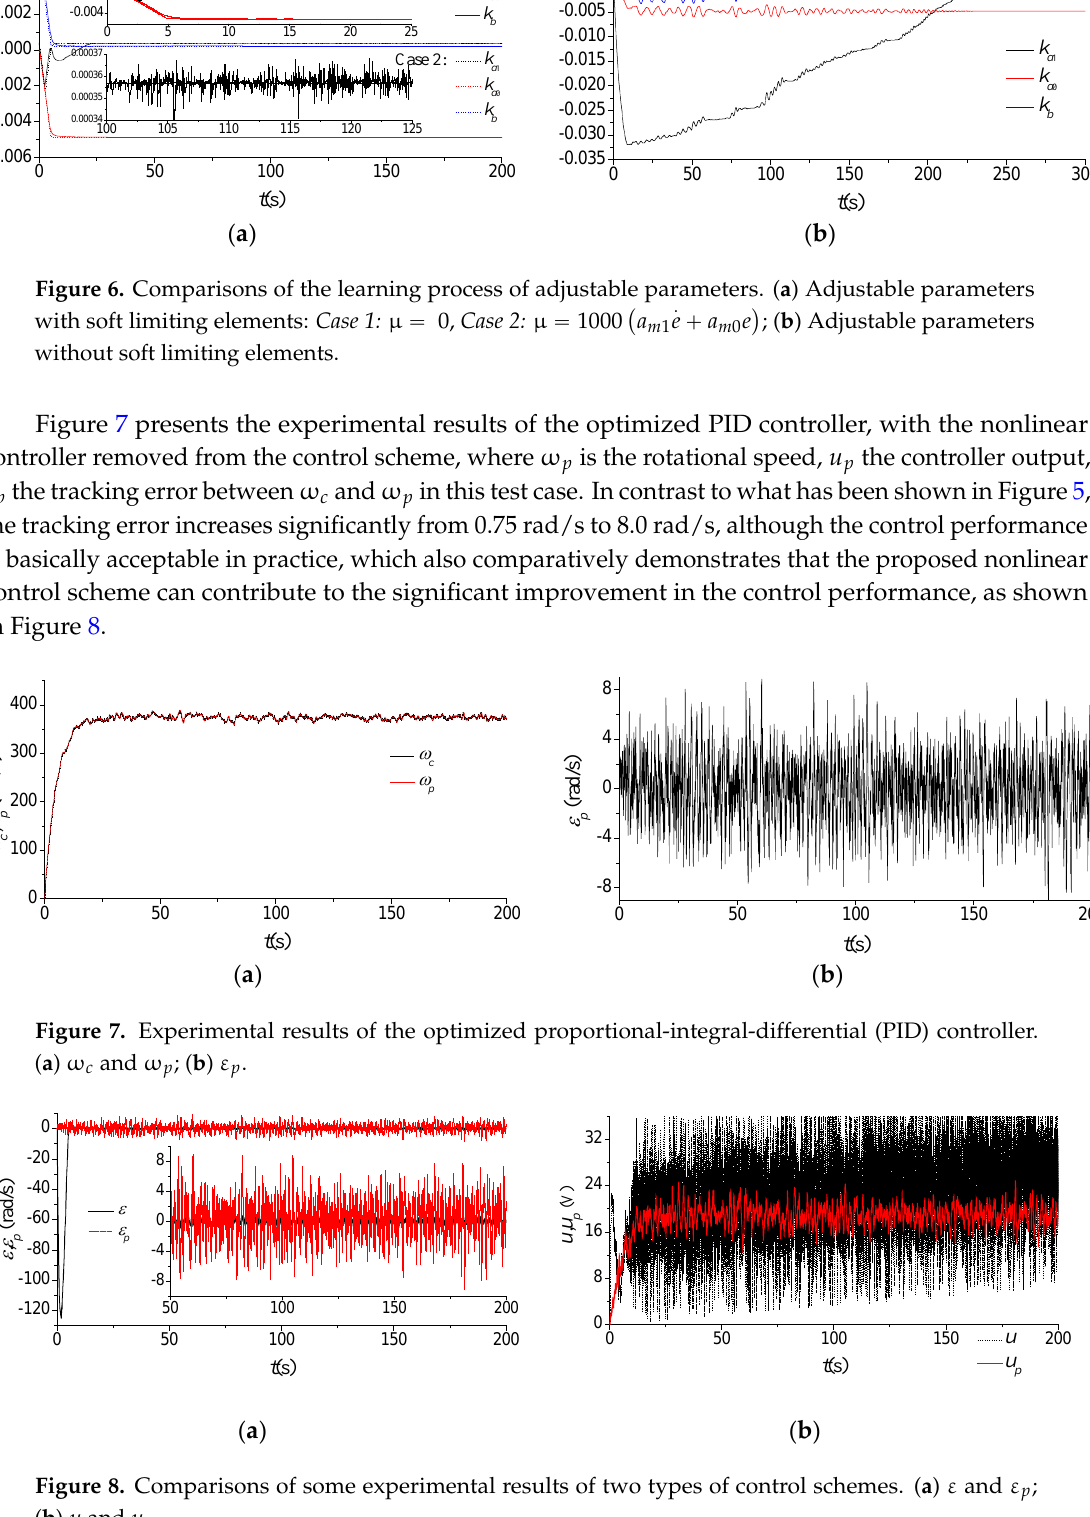
Figure 8. Comparisons of some experimental results of two types of control schemes. ( a ) ε and ε p ; ( b ) u and u p .